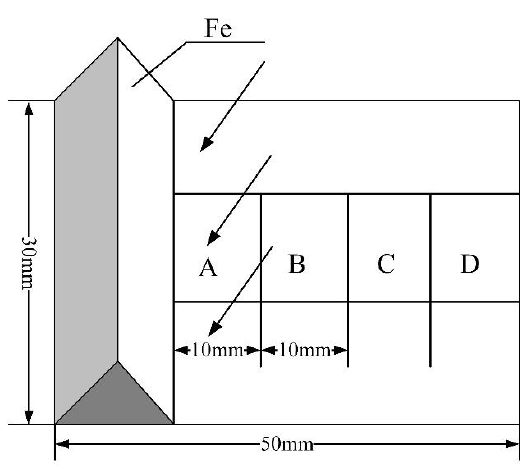
Figure 2. Impurity target structure: ridge structure.